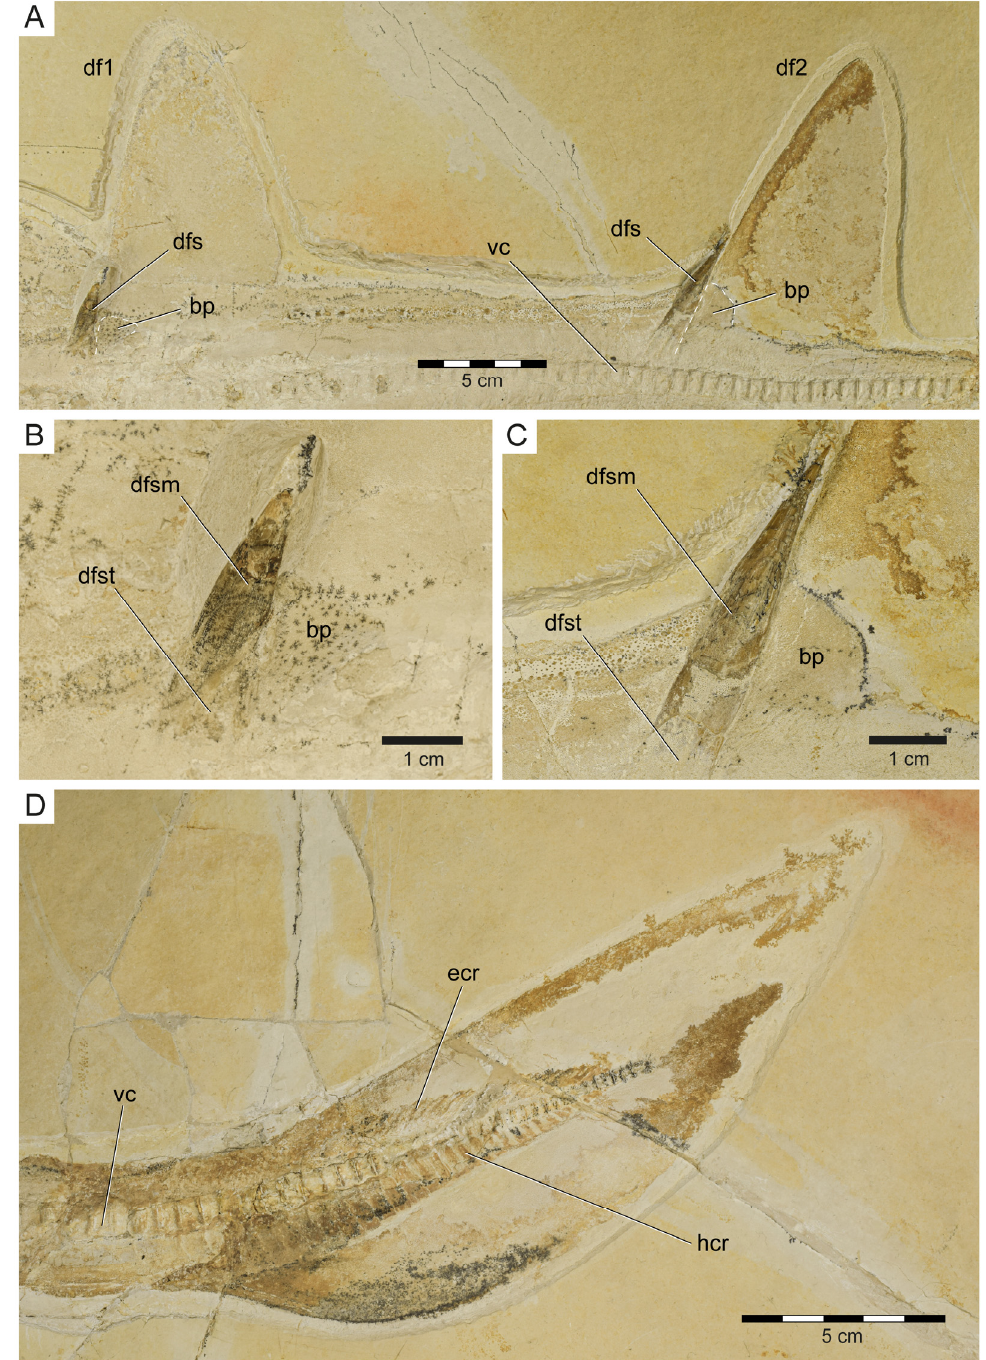
Figure 7. Dorsal and caudal fin of Protospinax annectans Woodward, 1918, PBP-SOL-8007, from the lower Tithonian of the Solnhofen Archipelago, Bavaria, Germany. ( A ) Dorsal fins with fin spines; ( B ) first dorsal fin spine; ( C ) second dorsal fin spine; ( D ) caudal fin. Abbreviations : bp , basal plate; df1 , first dorsal fin; df2 , second dorsal fin; dfs , dorsal fin spine; dfsm , dorsal fin spine mantle; dfst , dorsal fin spine trunk; ecr , epichordal radials; hcr , hypochordal radials; vc , vertebral